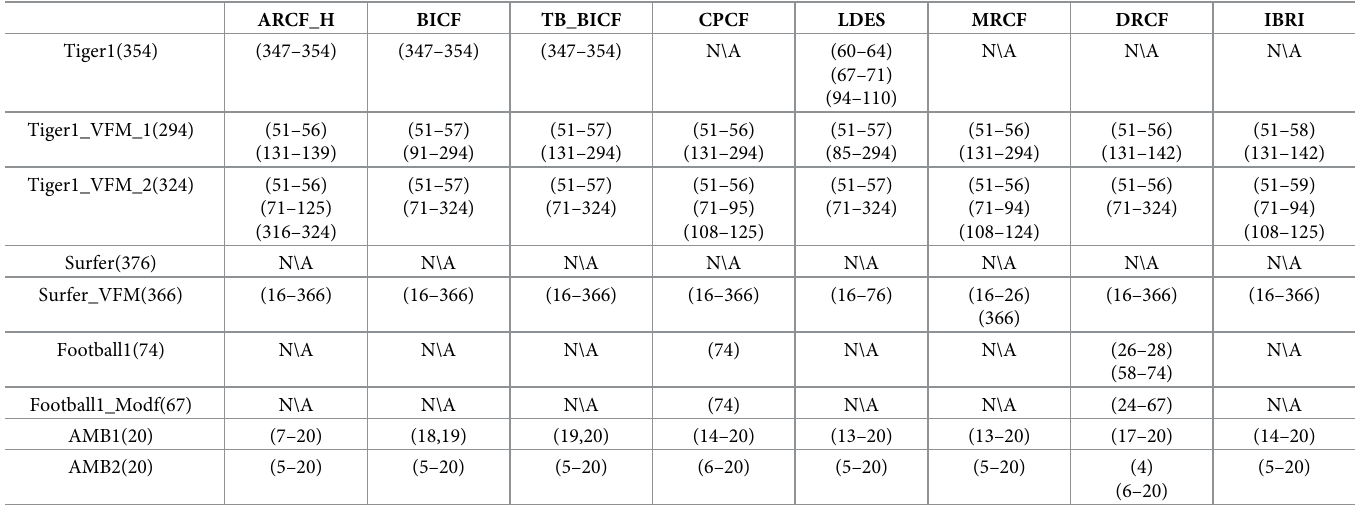
Table 4. The frame ranges of CF-based trackers when failing to capture